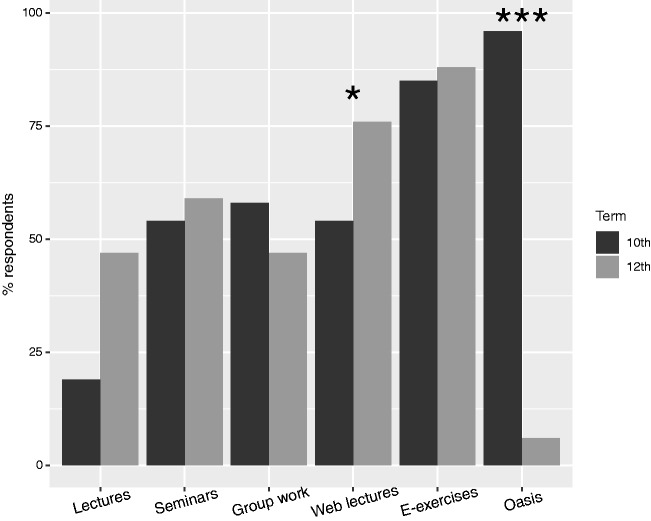
Student survey on activities that promote learning. The plot shows the proportion of students who responded “Agree” when asked if a given learning aid or activity promotes their learning. ***P < 0.001, *P < 0.05 Kruskal–Wallis test comparing the item’s Likert scores between the two student groups.